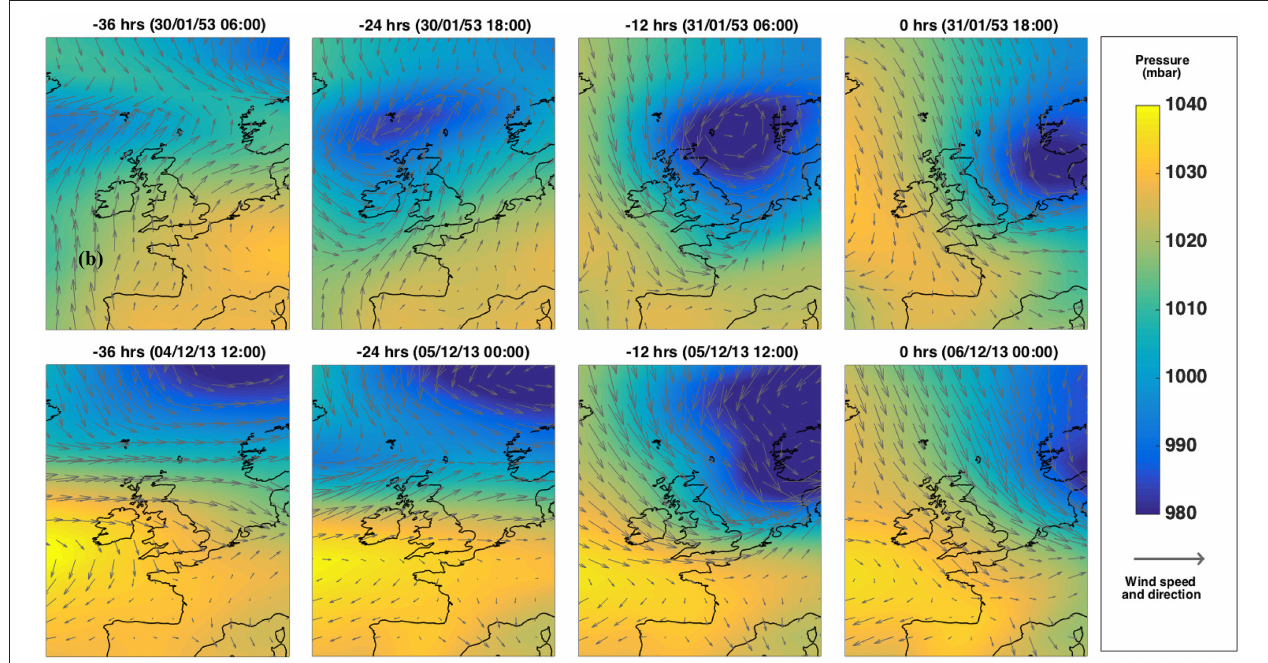
FIGURE 2 | Closer view of 12-hourly wind and pressure in the 1953 and 2013 events (0h is nearest pressure-wind reading to the time of the largest return period HW of each event in the UK Class A tide gauge database).